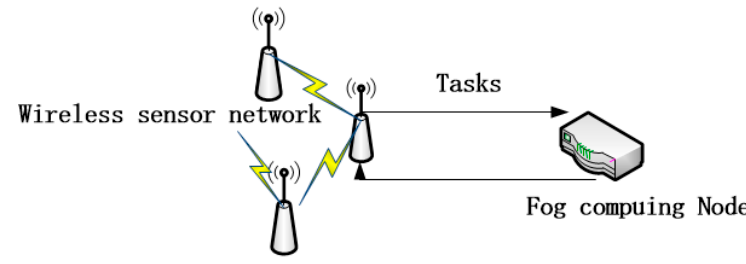
Figure 4. Wireless sensor network applications.